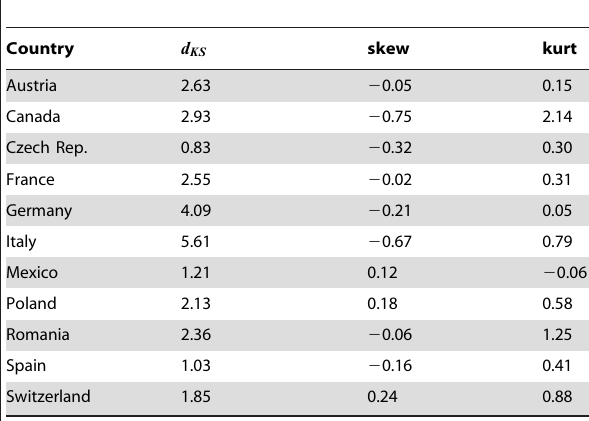
Table 5. KS distance ( d KS ) to a standardized Gaussian, and low-moment skewness (skew) and kurtosis (kurt) of aggregated distributions Q (cid:3) ( v ) .